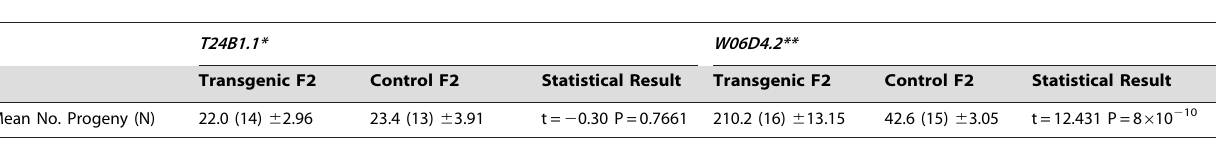
Table 2. Results from transformation rescue